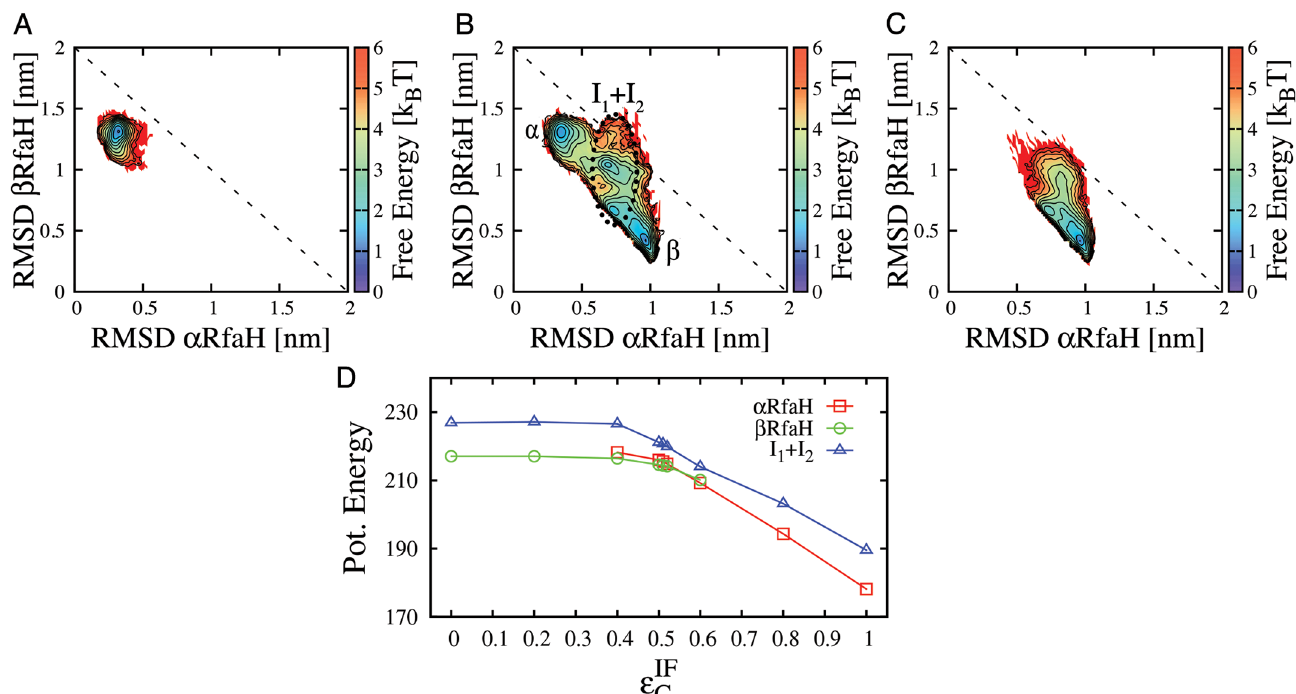
Fig 2. Coexistence of the α and β folds of RfaH can be tuned by changing the strength of interface contacts. Contour plots show 2D free energy profiles obtained from simulations of the full RfaH protein. The strength of the interdomain contacts ε IF C was equal to intradomain contacts (A), reduced in ~50% (B) or deleted (C). The reaction coordinates are RMSD of the CTD (residues 115 – 162) to either the all- α or the all- β crystal structures. The contour lines de fi ne steps of 0.5 k B T * and the temperature is 0.92 T F β . Interconversion between α and β goes through obligate intermediate states, indicated through a black dotted ellipse (B). The potential energy for the α , β , and intermediate ensembles is plotted in (D). While both the α and β con fi gurations can form interface contacts, α is able to form more and becomes relatively more energetically stable at high ε IF C . α is rarely sampled at ε IF C < 0 : 4 and β is rarely sampled at ε IF C > 0 : 6 . Despite its higher enthalpy, the disordered intermediate ensemble is sampled because of its larger